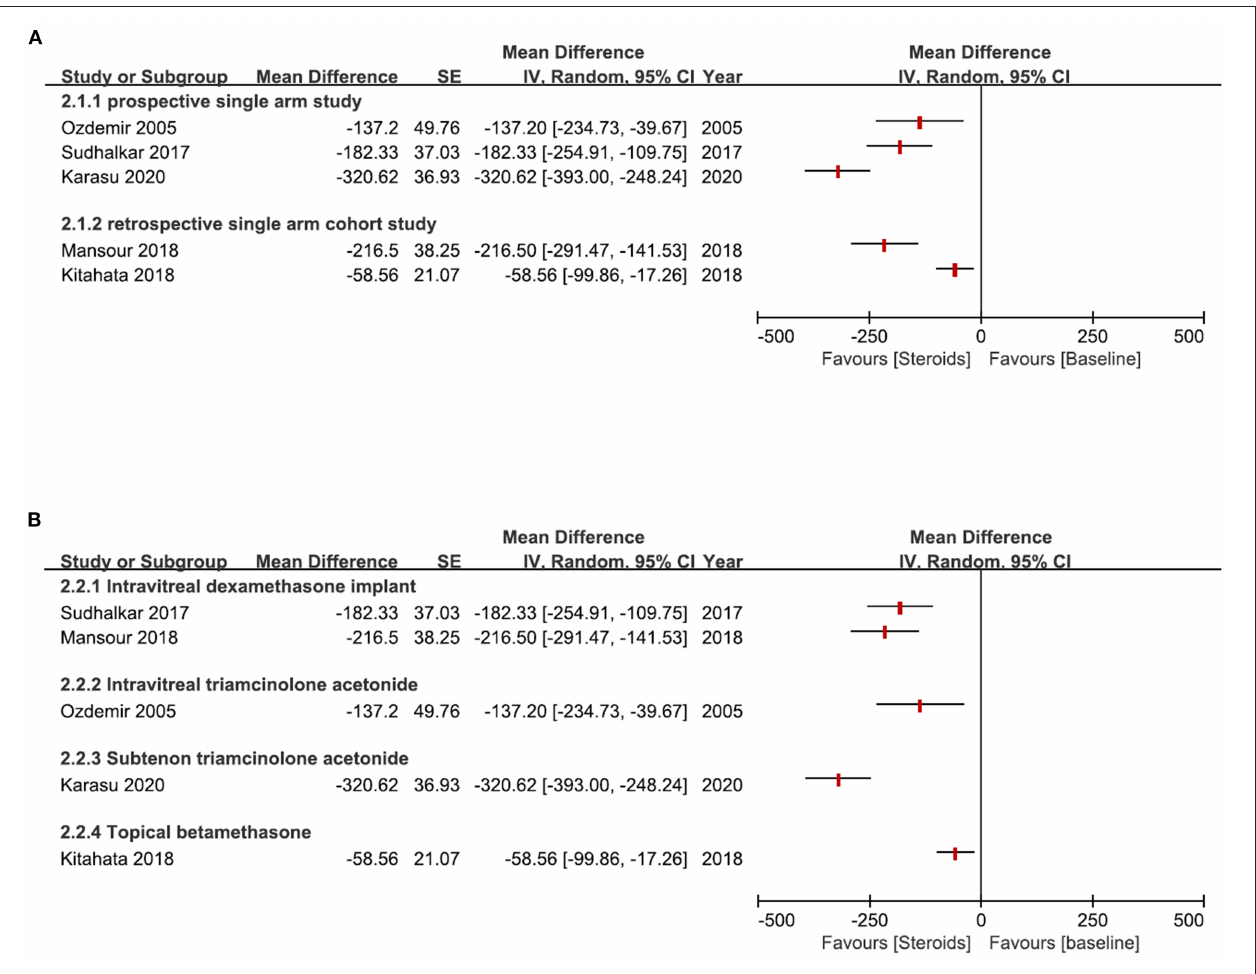
FIGURE 6 | Plots for the change of central macular thickness (CMT) ( µ m) from baseline after steroids treatment. (A) CMT change ( µ m) in different study types; (B) CMT change ( µ m) of different administration methods of steroids. [for the studies Ozdemir et al. (27) and Sudhalkar et al. (19), the change of CMT was calculated from published original individual data; For the study Kitahata et al. ( 37), the change of CMT was calculated from the mean/standard deviation data before and after treatment; For the studies Karasu (10) and Mansour et al. (11), the change of CMT was reported in the